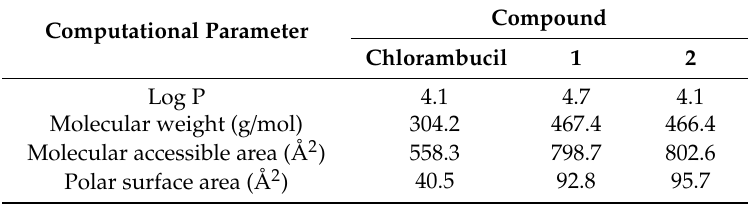
Table 1. Physicochemical properties of chlorambucil and its derivatives 1 and